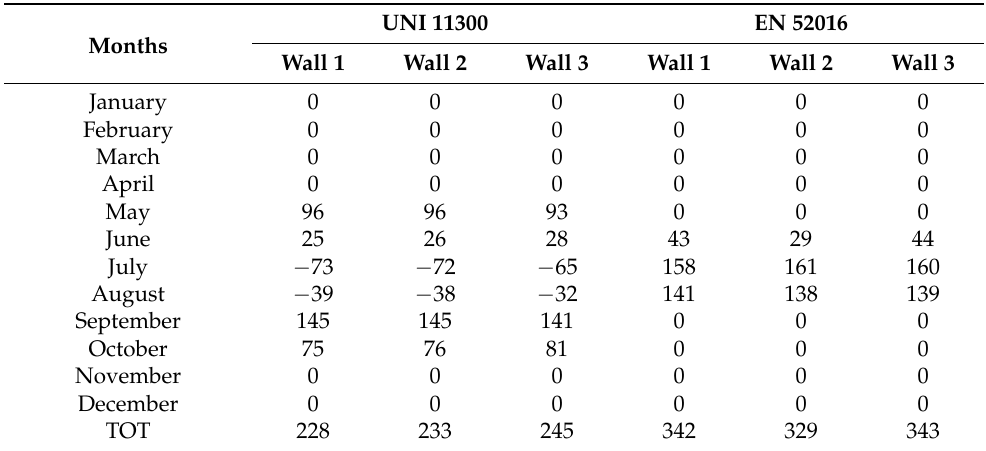
Table 9. Heat losses (kWh) during summer period through the walls of a case study (detached house): comparison between UNI 11300 and EN